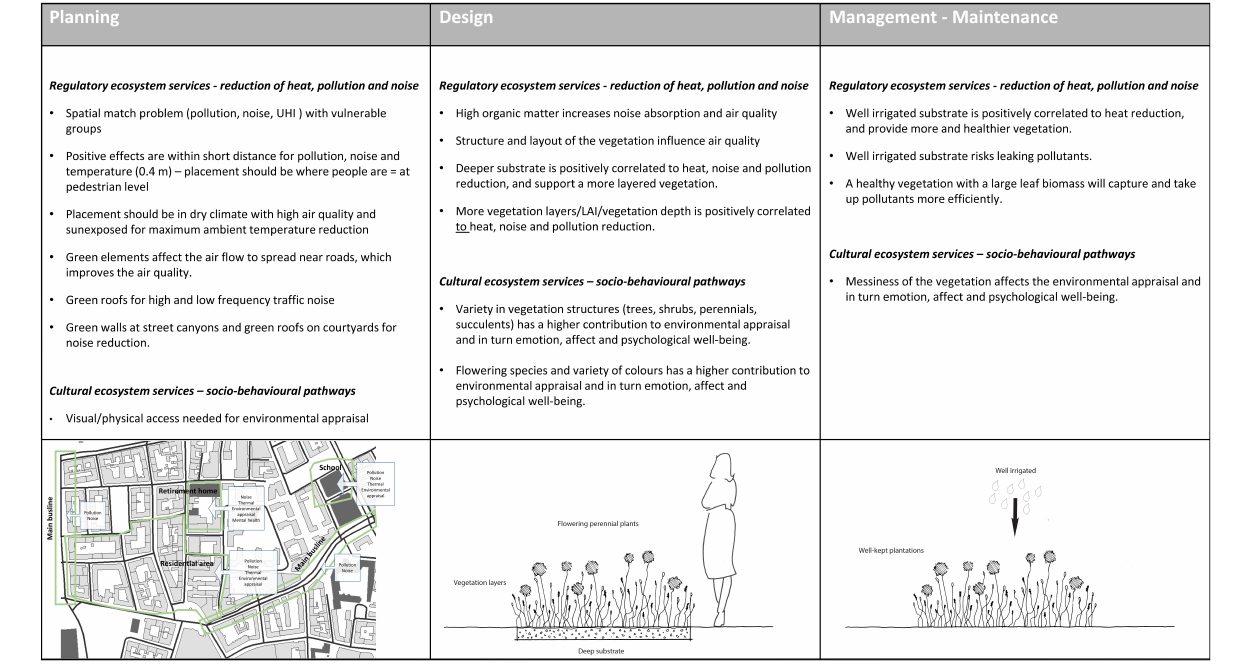
Frontiers in Ecology and Evolution |